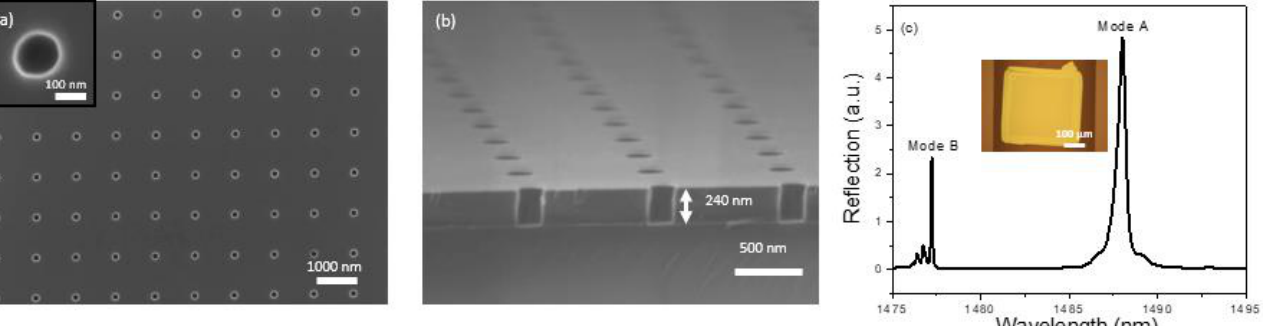
Figure 2. Characterization of a PCS sensor on SOI substrate and glass substrate. ( a ) Top view SEM image of the fabricated PCS sensor on SOI showing device parameters of a = 976 nm, r = 75 nm, t = 240 nm. The inset shows the top view for a single air hole in the PCS. ( b ) Cross sectional view SEM image of the PCS sensor on SOI. ( c ) Measured reflection spectrum of the PCS sensor on a glass substrate after transfer printing. Inset shows a microscope image of the PCS after transferring in a microfluidic channel.